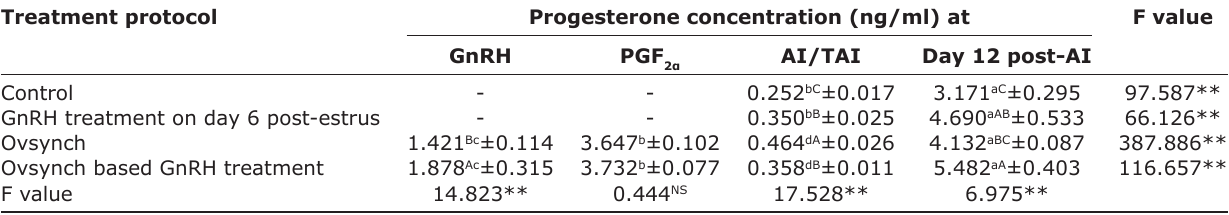
Table-1: Serum progesterone concentration at different days of treatment/AI in repeat breeding crossbred cows. Treatment protocol Progesterone concentration (ng/ml)